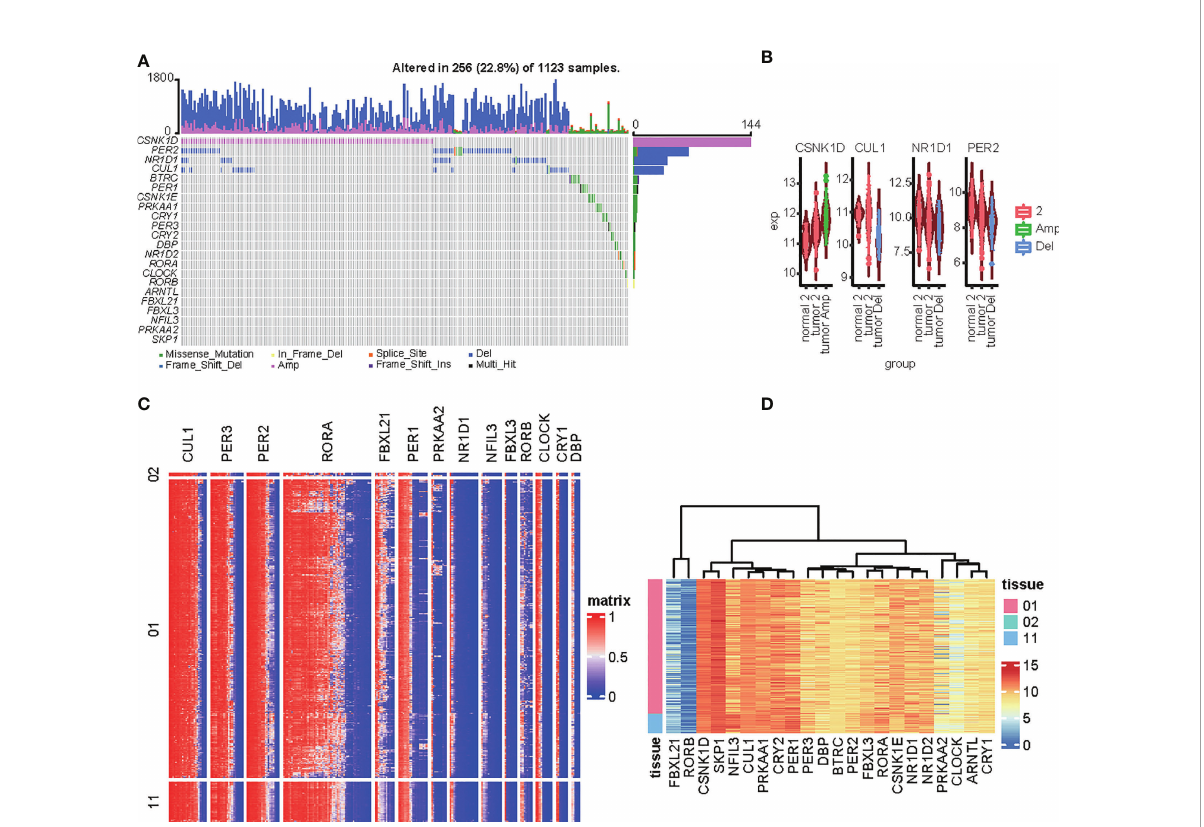
FIGURE 1 Genomic alterations to circadian-related genes in HCC tissues. (A) Oncoprint of 14 circadian-related genes in the TCGA LIH dataset generated by maftools. (B) Comparison of the expression of circadian-related genes among ampli fi cation, deletion, or normal in the LIHC dataset. (C, D) Heatmap of the circadian-related gene methylation types (C) and expression (D) in the LIHC